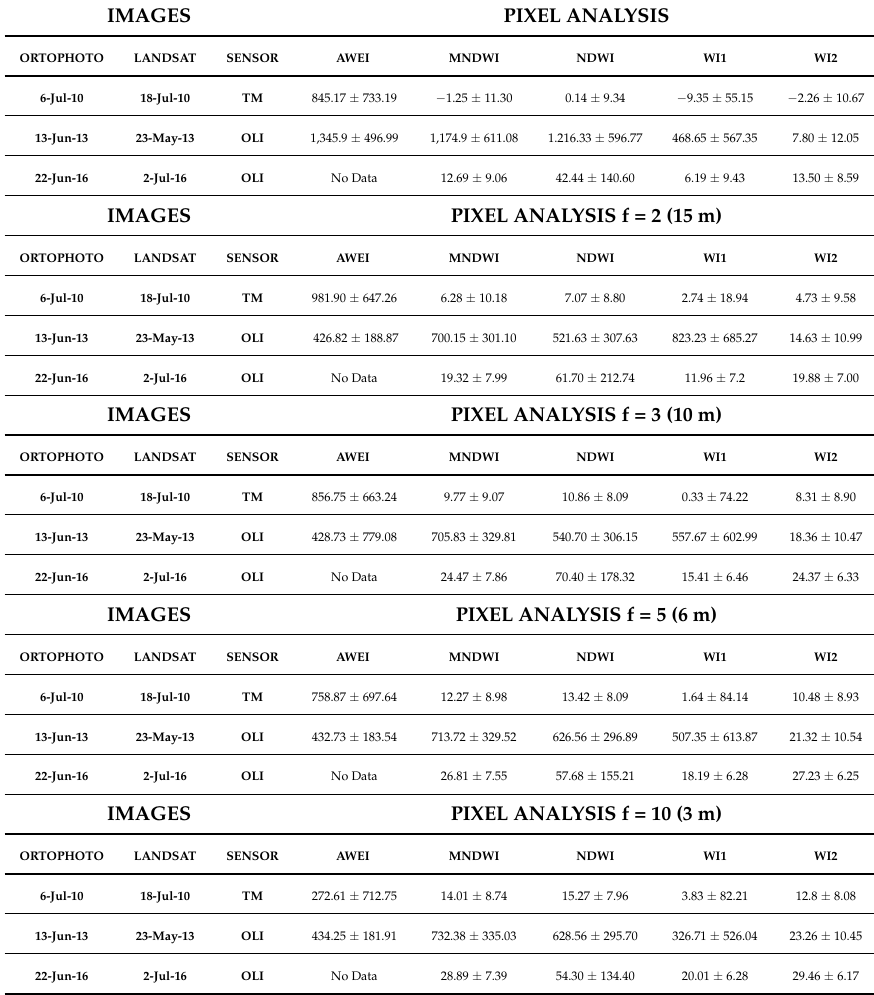
Table A5. Bias comparison (mean ± standard deviation) between Landsat images analyzed and high-resolution ortophotos at the pixel level in the Adra River